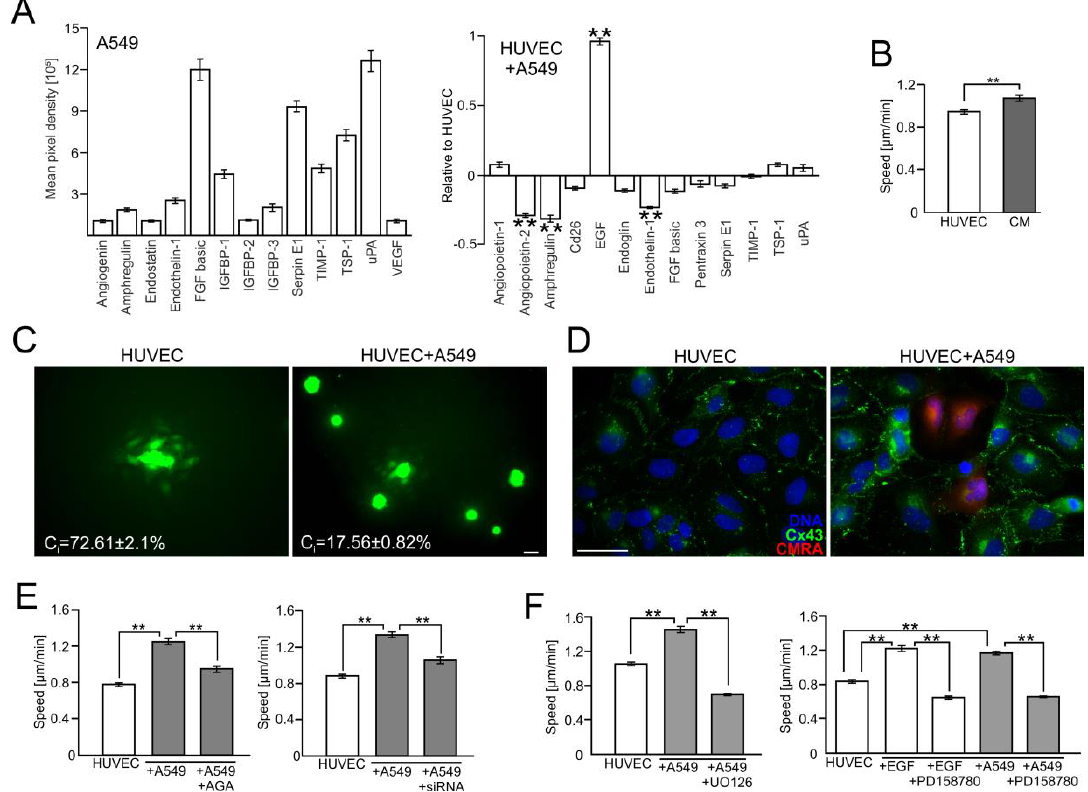
Figure 2. A549 cells impair the endothelial barrier function via the activation of the Cx43/EGF/ERK1/2- dependent intercellular signaling axis. ( A ) A549 cells were seeded onto HUVEC monolayers as